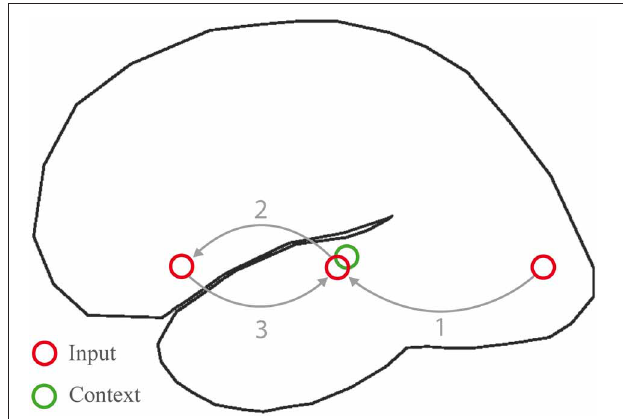
FIGURE 8 | Processing cycle subserving word meaning comprehension in the left hemisphere language network. Inputs are conveyed from sensory regions (here visual cortex) to the inferior, middle and superior temporal gyri (1), where lexical information is activated. Signals are hence relayed to the inferior frontal gyrus (2), where neurons respond with a sustained firing pattern. Signals are then fed back into the same regions in temporal cortex from where they were received (3). A recurrent network is thus set up, which allows information to be maintained on-line, a context (green circle) to be formed during subsequent processing cycles, and incoming words to be unified within the